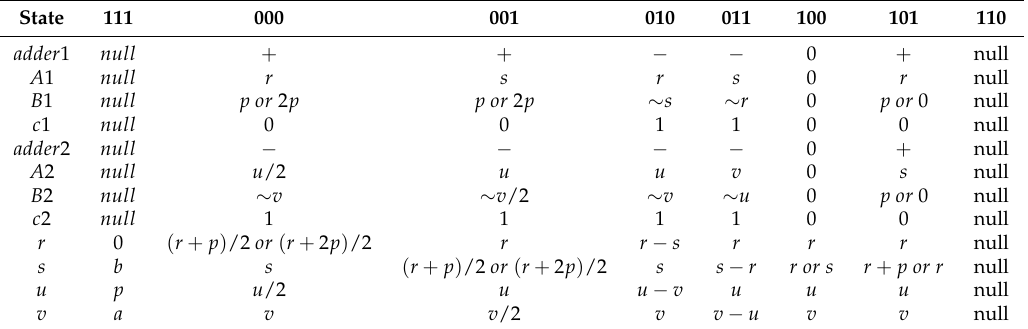
Table 1. Inversion state and Mux.